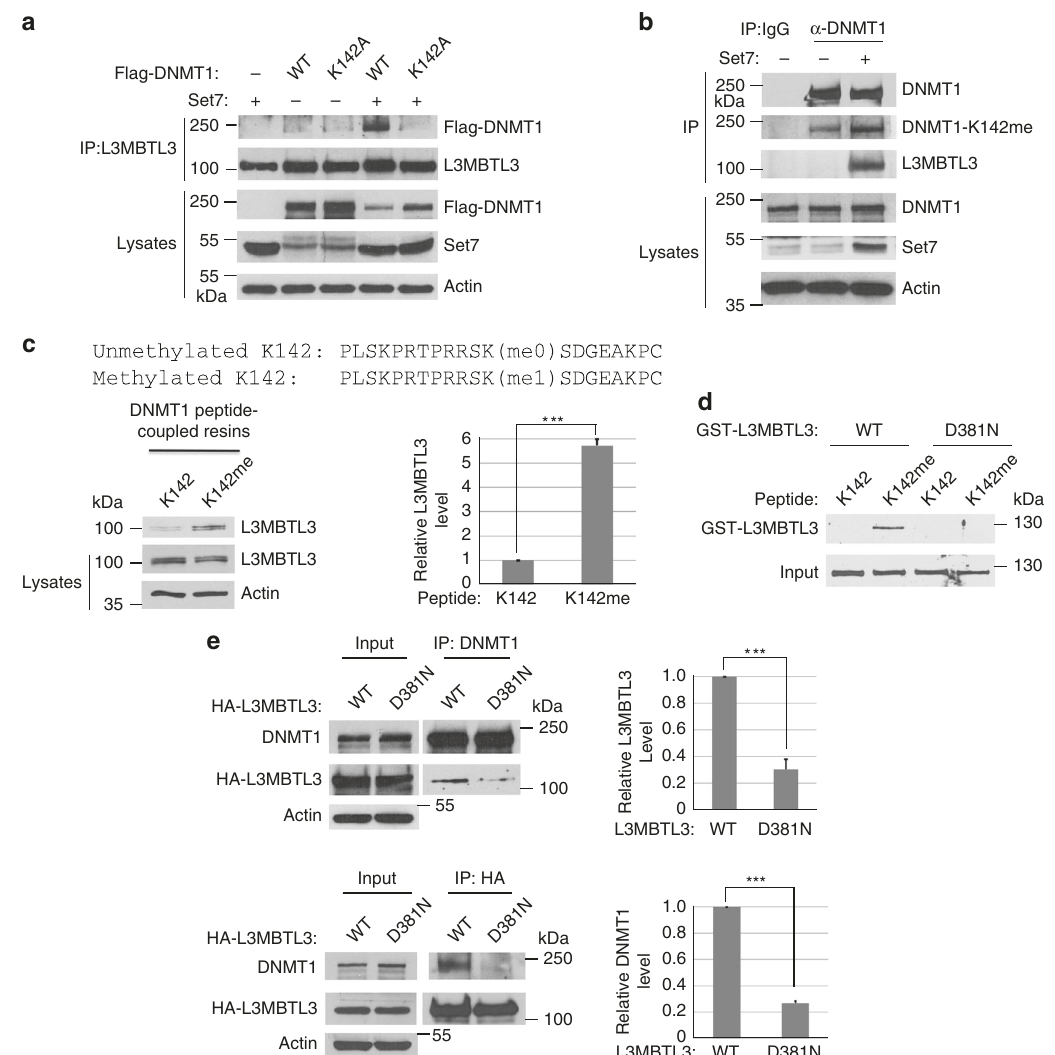
Fig. 5 L3MBTL3 interacts with the methylated K142 to regulate the stability of the methylated DNMT1 protein. a The interaction between L3MBTL3 and DNMT1 is dependent on SET7 and K142. The Flag-WT-DNMT1 and its K142A mutant and SET7 constructs were co-transfected into HCT116 cells. The interactions of DNMT1 and the mutant with L3MBTL3 were analyzed by anti-L3MBTL3 immunoprecipitation and western blotting as indicated. b SET7 stimulated the methylation of K142 and interaction between DNMT1 and L3MBTL3. SET7 expression constructs were transfected into HCT116 cells. The interactions between DNMT1 and L3MBTL3 and the methylated DNMT1 were analyzed by immunoprecipitation and western blotting with anti- methylated K142 and other indicated antibodies. c L3MBTL3 preferentially binds to the monomethylated K142 peptide. Sulfolink-immobilized DNMT1 peptides containing the monomethylated (Kme1) or cognate unmethylated K142 (Kme0) were incubated with 250 μ g of HCT116 extracts for 4 h. L3MBTL3 binding to the peptide resins was analyzed by anti-L3MBTL3 Western blotting and quanti fi ed with independent Student ’ s t-test. *** P < 0.001. d L3MBTL3 directly interacts with the monomethylated K142 peptide. The K142me0 and Kme1 peptide resins were pre-incubated with 5 μ g of GST for 2 h to reduce the background. The resins were then incubated with 1.5 μ g of GST-L3MBTL3 or its D381N mutant for 4 h at 4 °C as indicated. The washed resins were blotted with anti-L3MBTL3 antibodies. e Mutation of the MBT domain in L3MBTL3 reduces its binding to DNMT1 in vivo. HA-tagged L3MBTL3 (WT) and the D381N mutant expression constructs were transfected into HCT116 cells for 42 h and then treated with MG-132 for additional 6 h. The interaction between DNMT1 and the wild-type or mutant HA-L3MBTL3 proteins were examined by reciprocal immunoprecipiation and western blotting with anti-DNMT1 or anti-HA antibodies. Student ’ s t -test was calculated for signi fi cant differences. ***P < 0.001. All quanti fi cations were represented by bar graph with mean and S.D. for error bars from three replicates and all experiments were repeated three independent times with the same